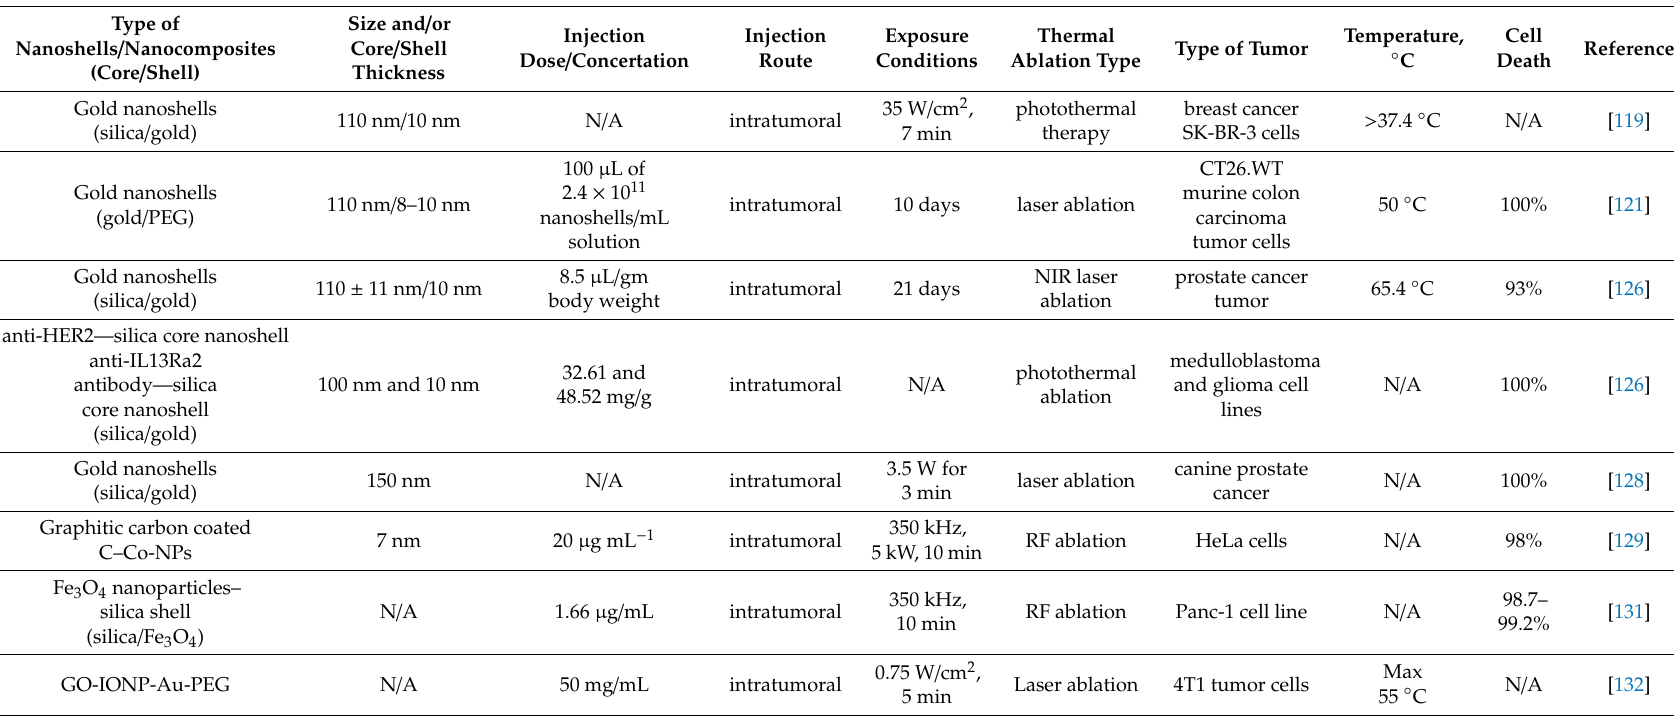
Table 6. Summary of gold nanoshells / nanocomposite application in thermal ablation of cancer (NIR: near